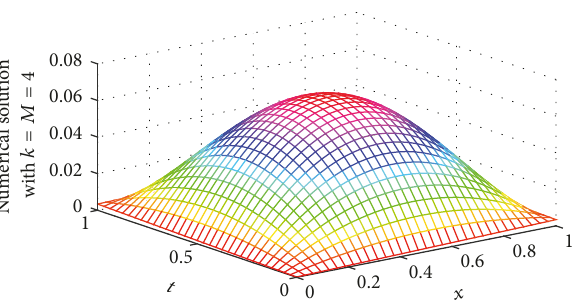
Figure 4: Numerical solution with 𝑘 = 𝑀 = 4 .